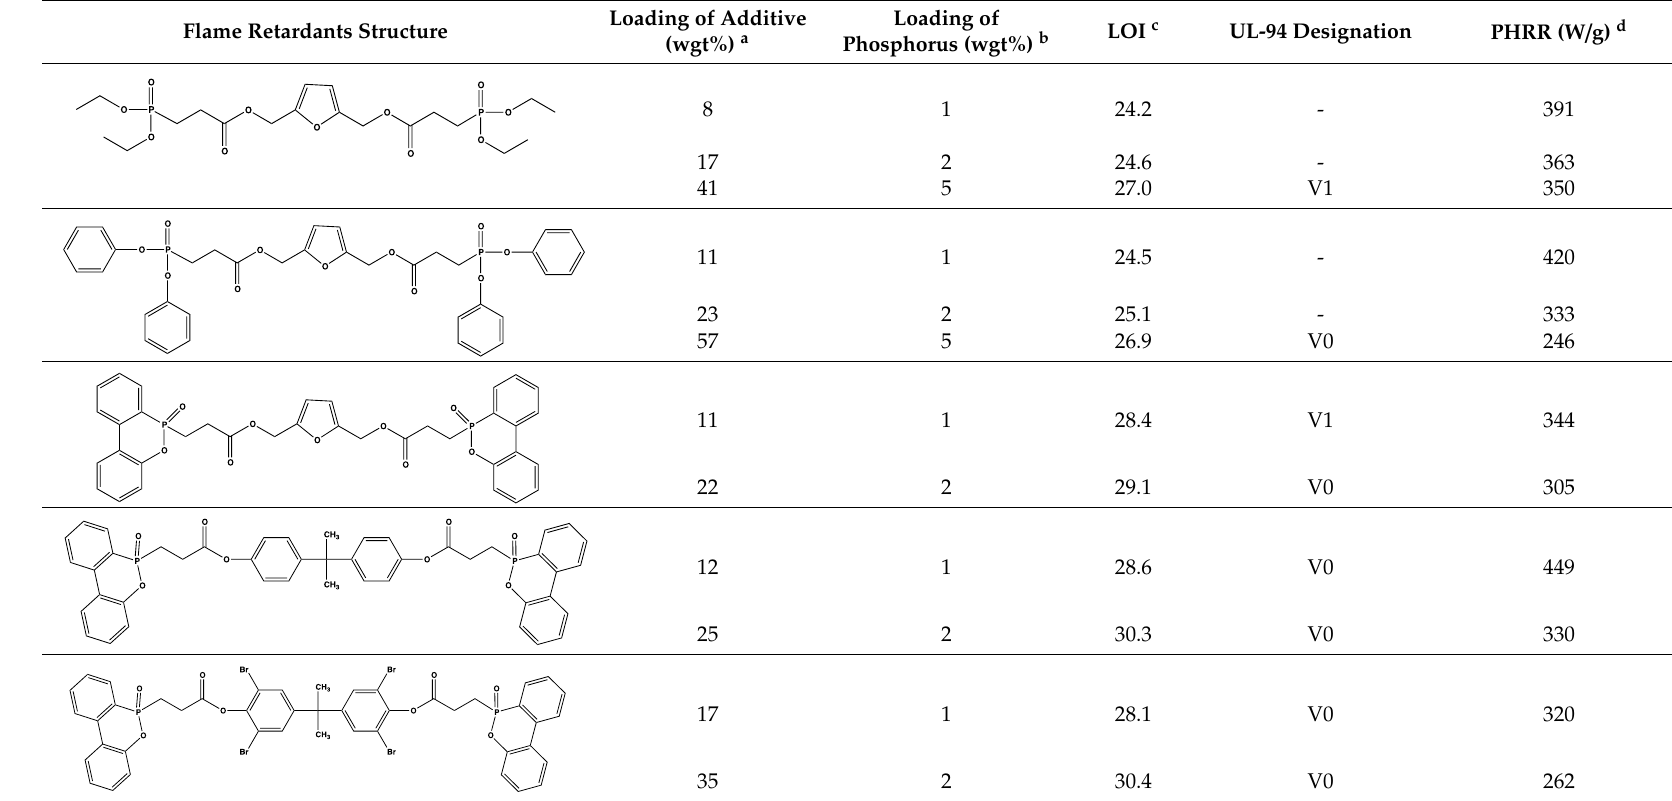
Table 4. Flammability data for blends of flame retardants with DGEBA epoxy resin.